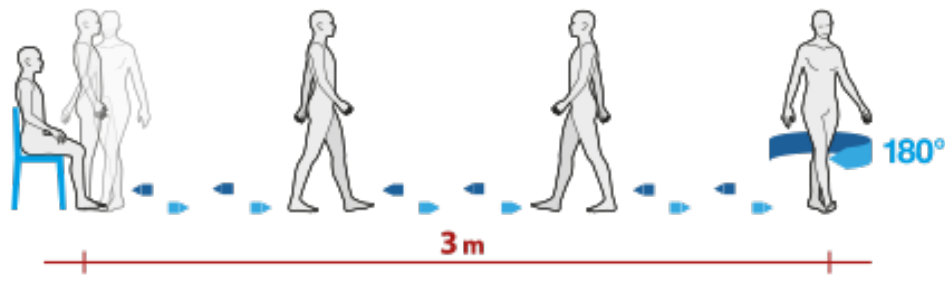
Figure 4. Graphical representation of the TUG